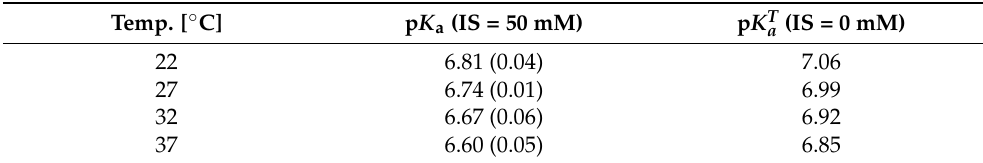
Table 1. The p K a values of FITC determined at various temperatures using the MST technique, before and after the correction of the ionic strength